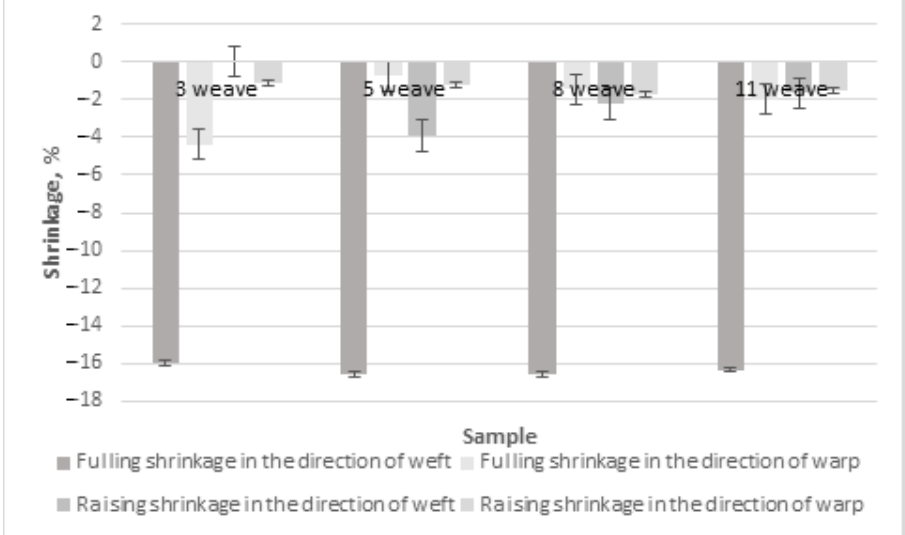
Figure 6. Fulling and raising shrinkage in the directions of the warp and weft of Series 1 fabrics with regenerated wool.